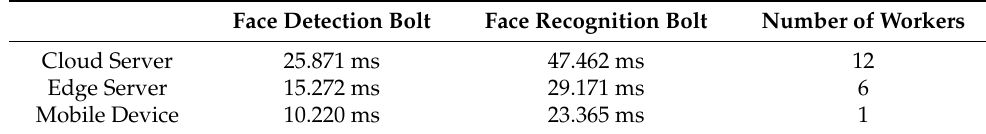
Table 2. Latency benchmark results.